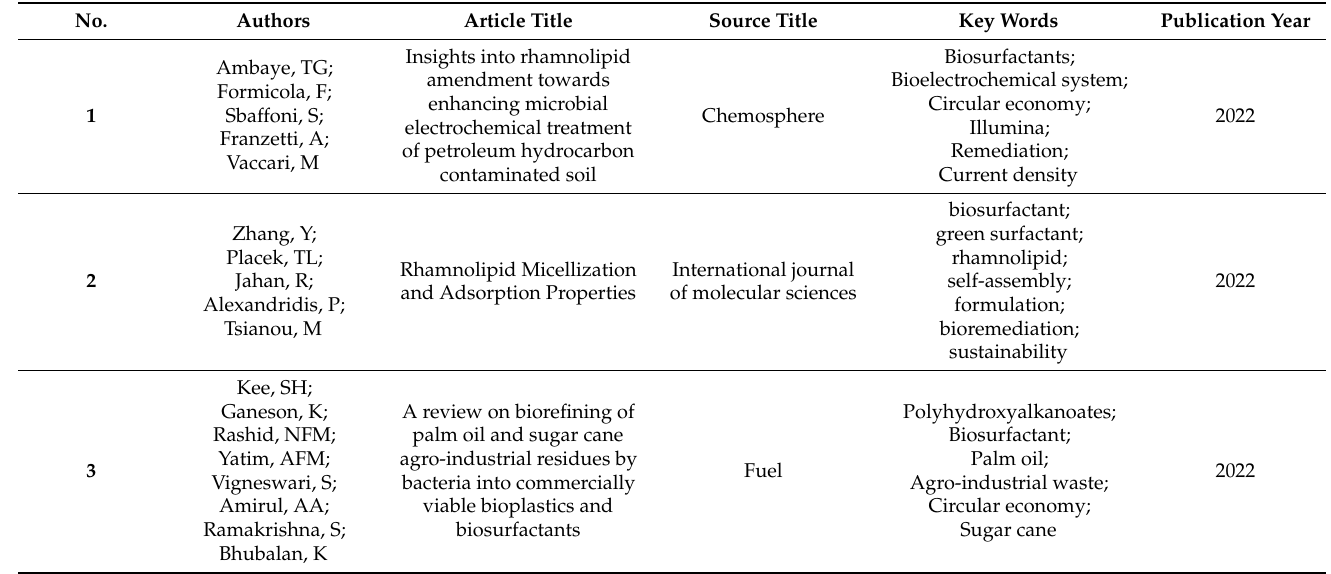
Table A1. Final sample of papers included in the